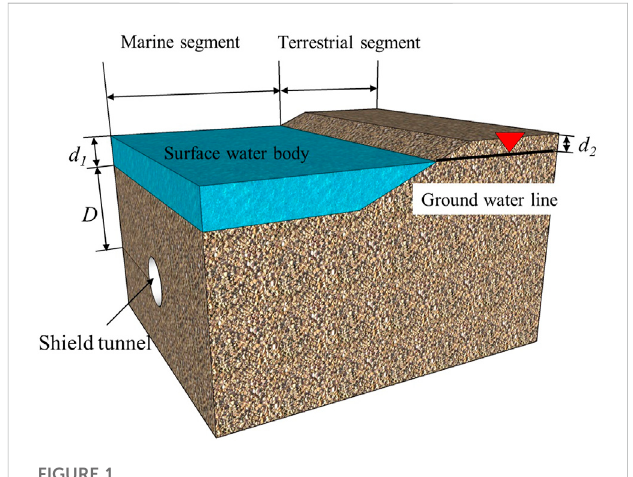
FIGURE 1 Schematic diagram of underwater shield